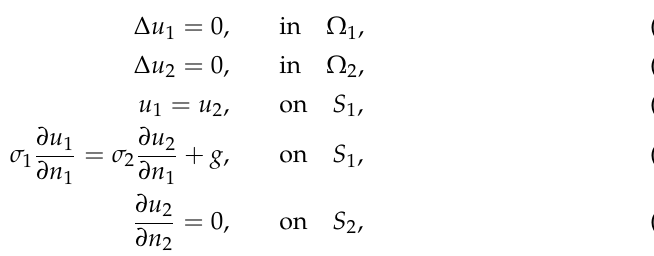
Figure 1. Two representations of region Ω = Ω 1 region Ω , ( b ) Irregular region Ω